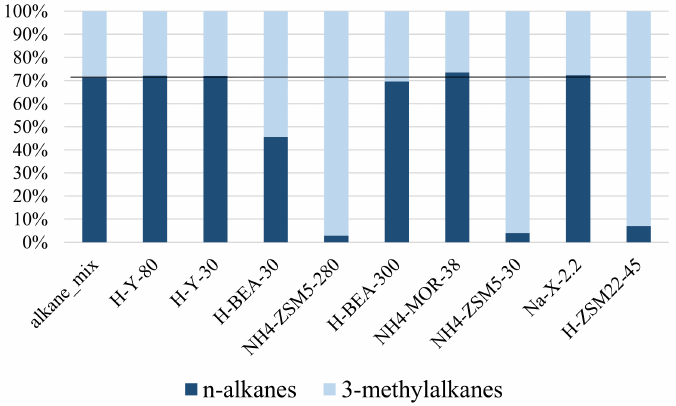
Figure 3. Distribution of n-alkanes and 3-methylalkanes in the synthetic alkane mixture and the extracts of the zeolites loaded with this solution. The n-alkanes are n-C 27 and n-C 29 , while the 3-methylalkanes are 3-methylpentacosane and its side-products 3-methyl (C 24 , C 26 and C 27 ) with 3-methylpentacosane as main component. The black line shows the distribution in the reference sample